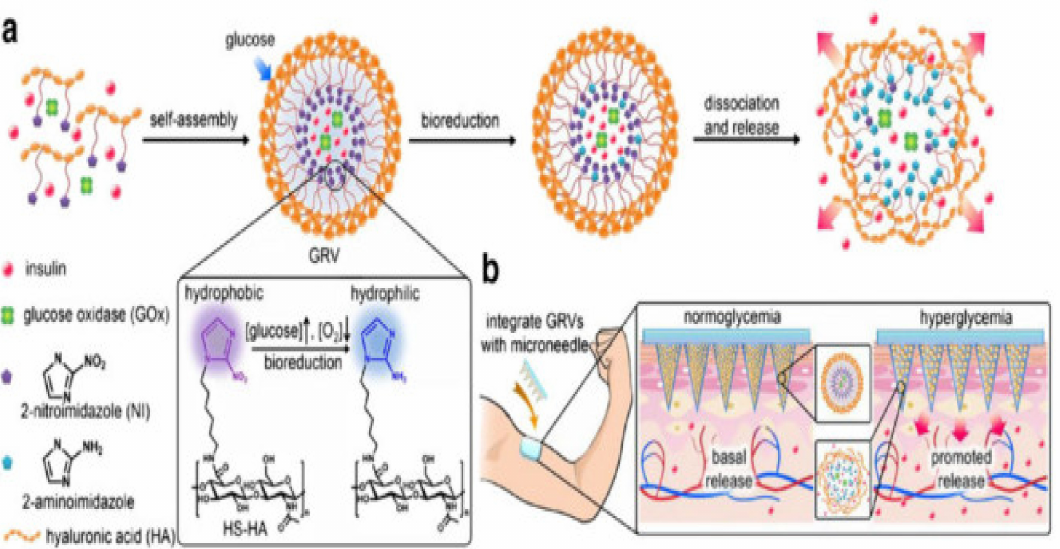
Figure 16. MNs for delivery of insulin ( a ) Formation and mechanism of GRVs composed of HS-HA. ( b ) Schematic of the GRV-containing MN-array patch (smart insulin patch) for in vivo insulin delivery triggered by a hyperglycemic state to release more insulin [238]. (Adapted from Ref.